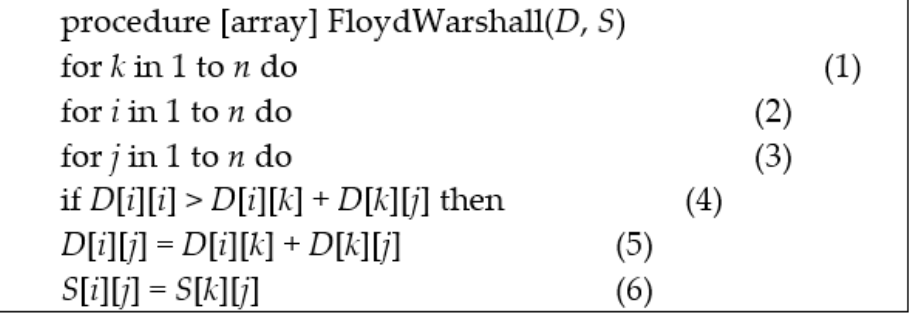
Figure 3. Typical Floyd–Warshall pseudo-code.